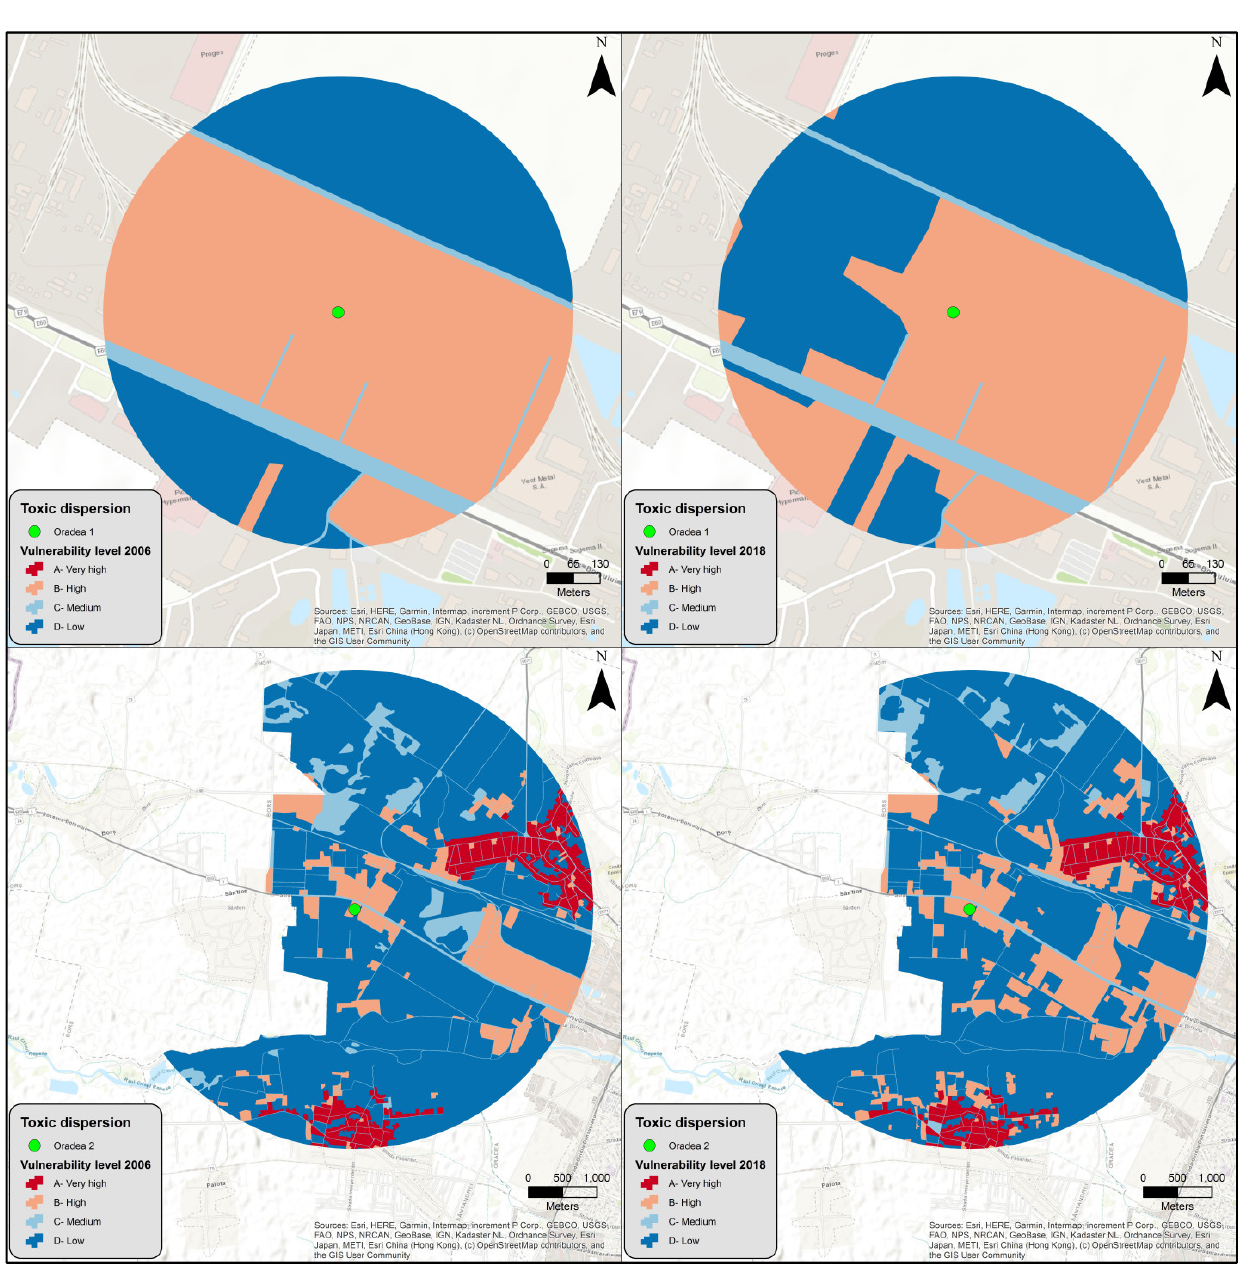
Figure 11. Vulnerability temporal variation within the reversible effects area for Oradea 1 ( top ) and Oradea 2 ( bottom )—worst-case scenario (toxic dispersion).